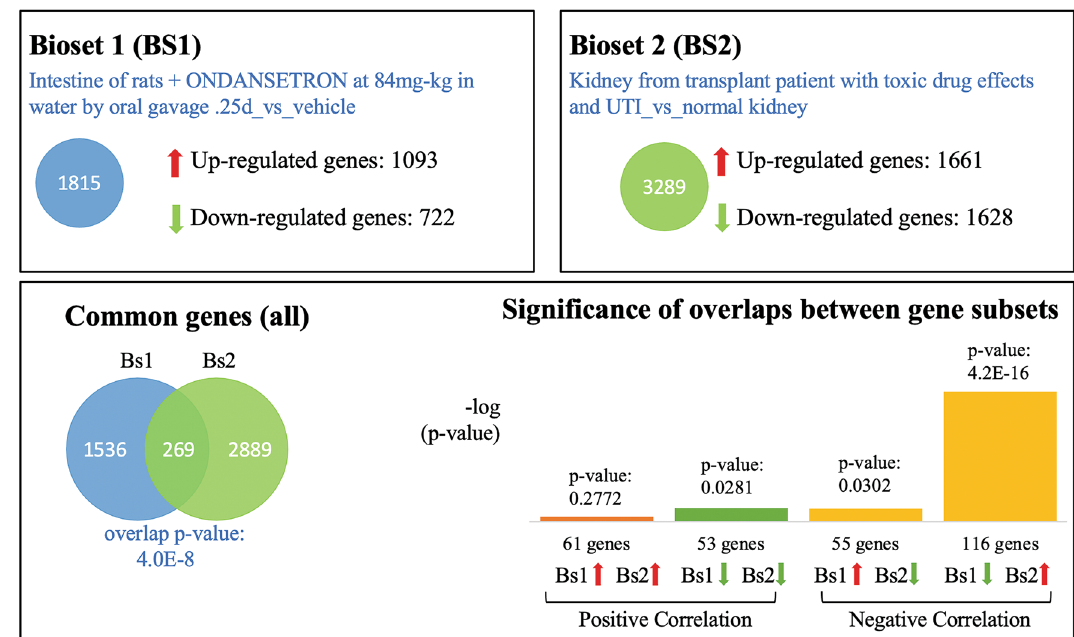
Figure 1. Detailed comparison between ondansetron-induced gene expression profile and kidney from transplant patients with toxic drug effects.